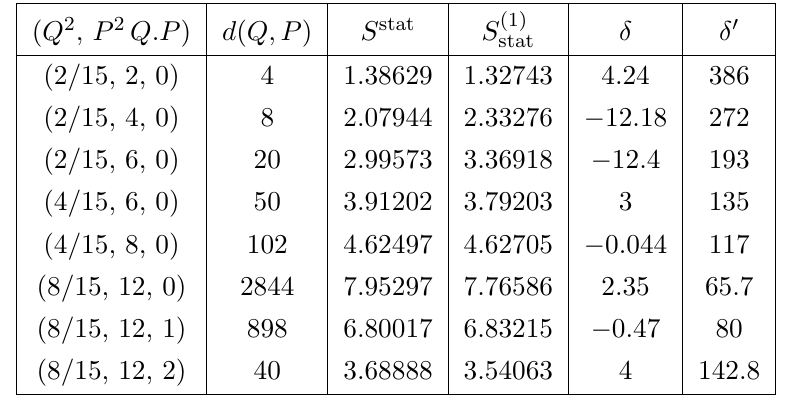
Table 15 . Comparison of the statistical entropy and statistical entropy at one loop for 15A/B